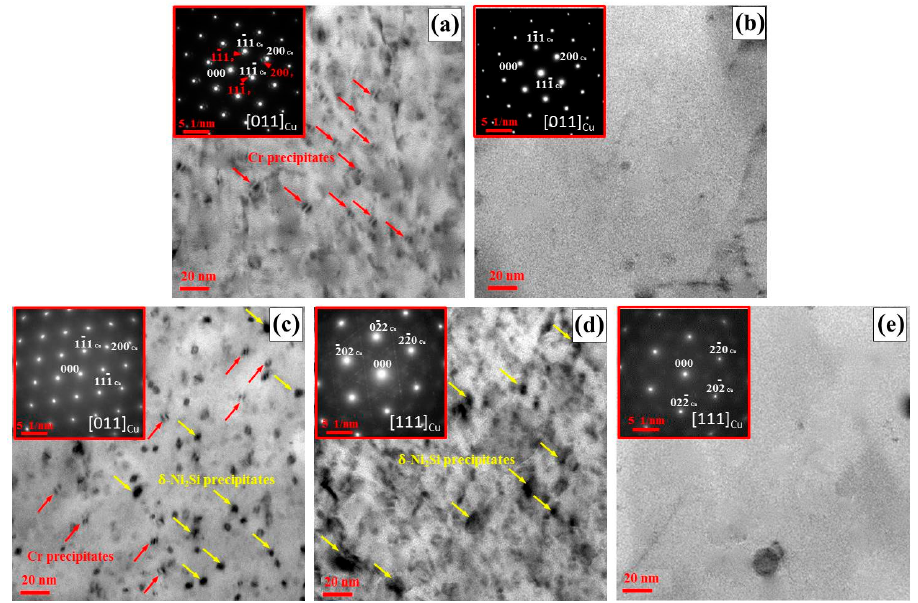
Figure 7. The bright-field TEM micrographs of samples from different zones at the rotational speed of 1400 rpm (condition A5). ( a ) CuCrZr-BM in the [011] Cu direction; ( b ) CuCrZr-NZ in the [011] Cu direction; ( b ) CuNiCrSi-BM in the [011] Cu direction; ( d ) CuNiCrSi-BM in the [111] Cu direction; ( e ) CuNiCrSi-NZ in the [111] Cu direction.